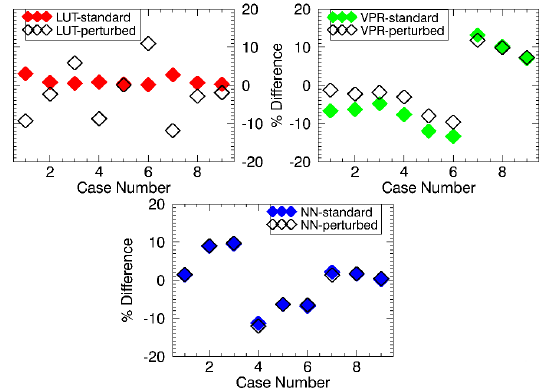
Figure 2 : Ash mass percentage differences. LUT (top left), VPR (top right) and NN (bottom) retrievals.